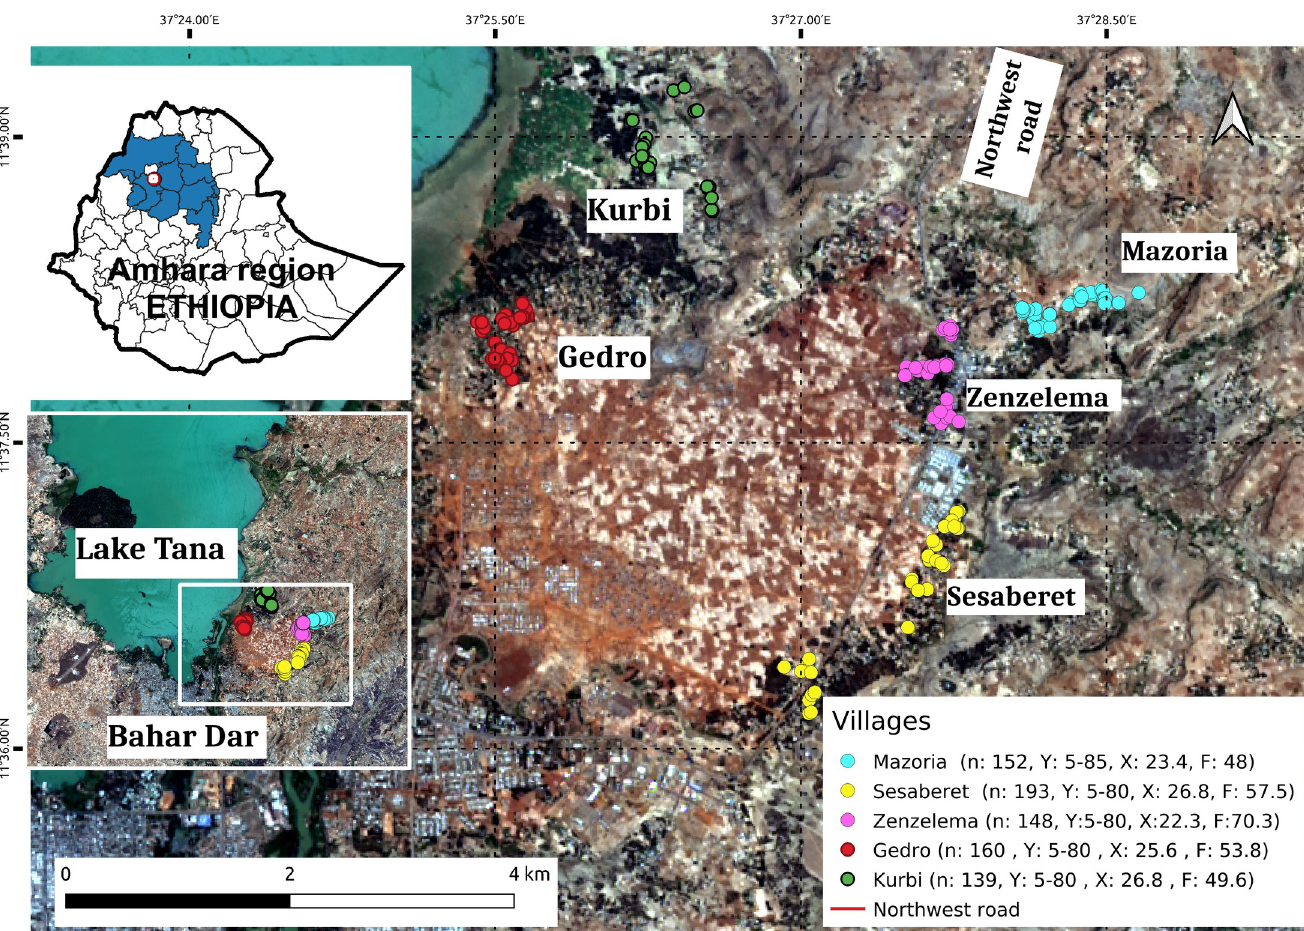
Fig 1. Study area in Amhara Region, Ethiopia. The villages included in this study were Kurbi, Gedro, Mazoria, Sesaberet and Zenzelema, belonging to a rural district. The number of people (n) recruited per village as well as their age range in years (Y), average age (X) and distribution by sex (F = % female) are noted in the box on the right hand corner. Landsat-8 images, "Image courtesy of the U.S. Geological Survey", downloaded from the US Geological Survey server (USGS, https:// www.usgs.gov) using Earth Explorer platform (https://earthexplorer.usgs.gov). The geographical location for Landsat-8 is: Path 170, Row 52. DATE_ACQUIRED =